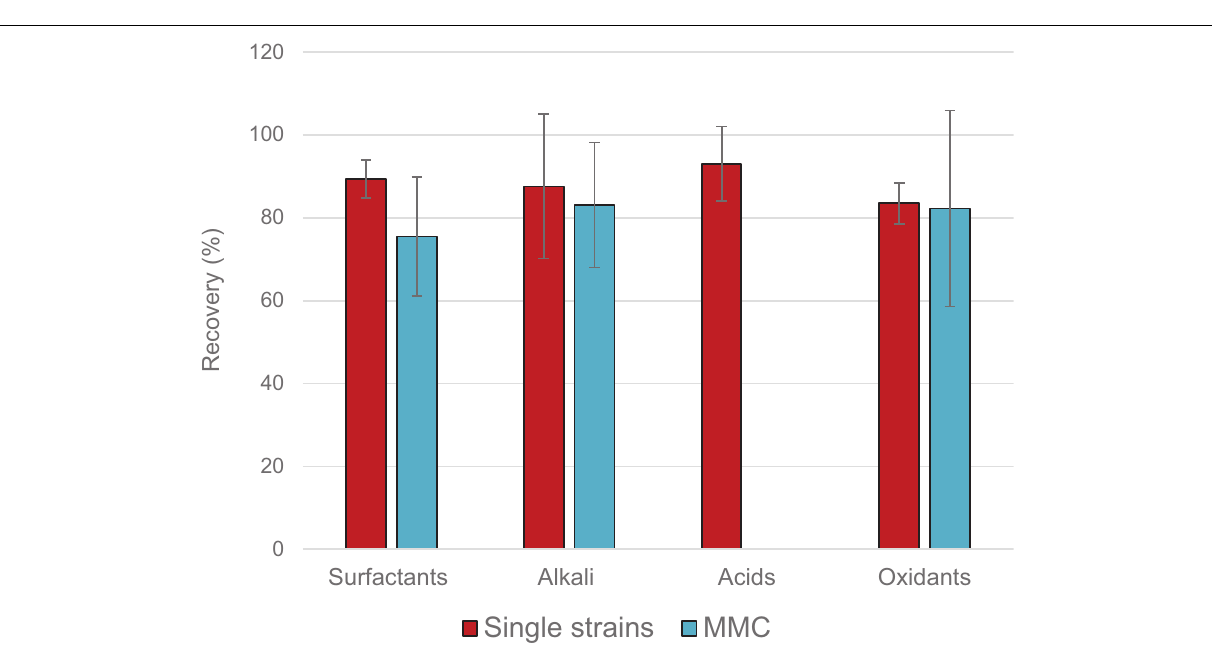
Frontiers in Bioengineering and Biotechnology |